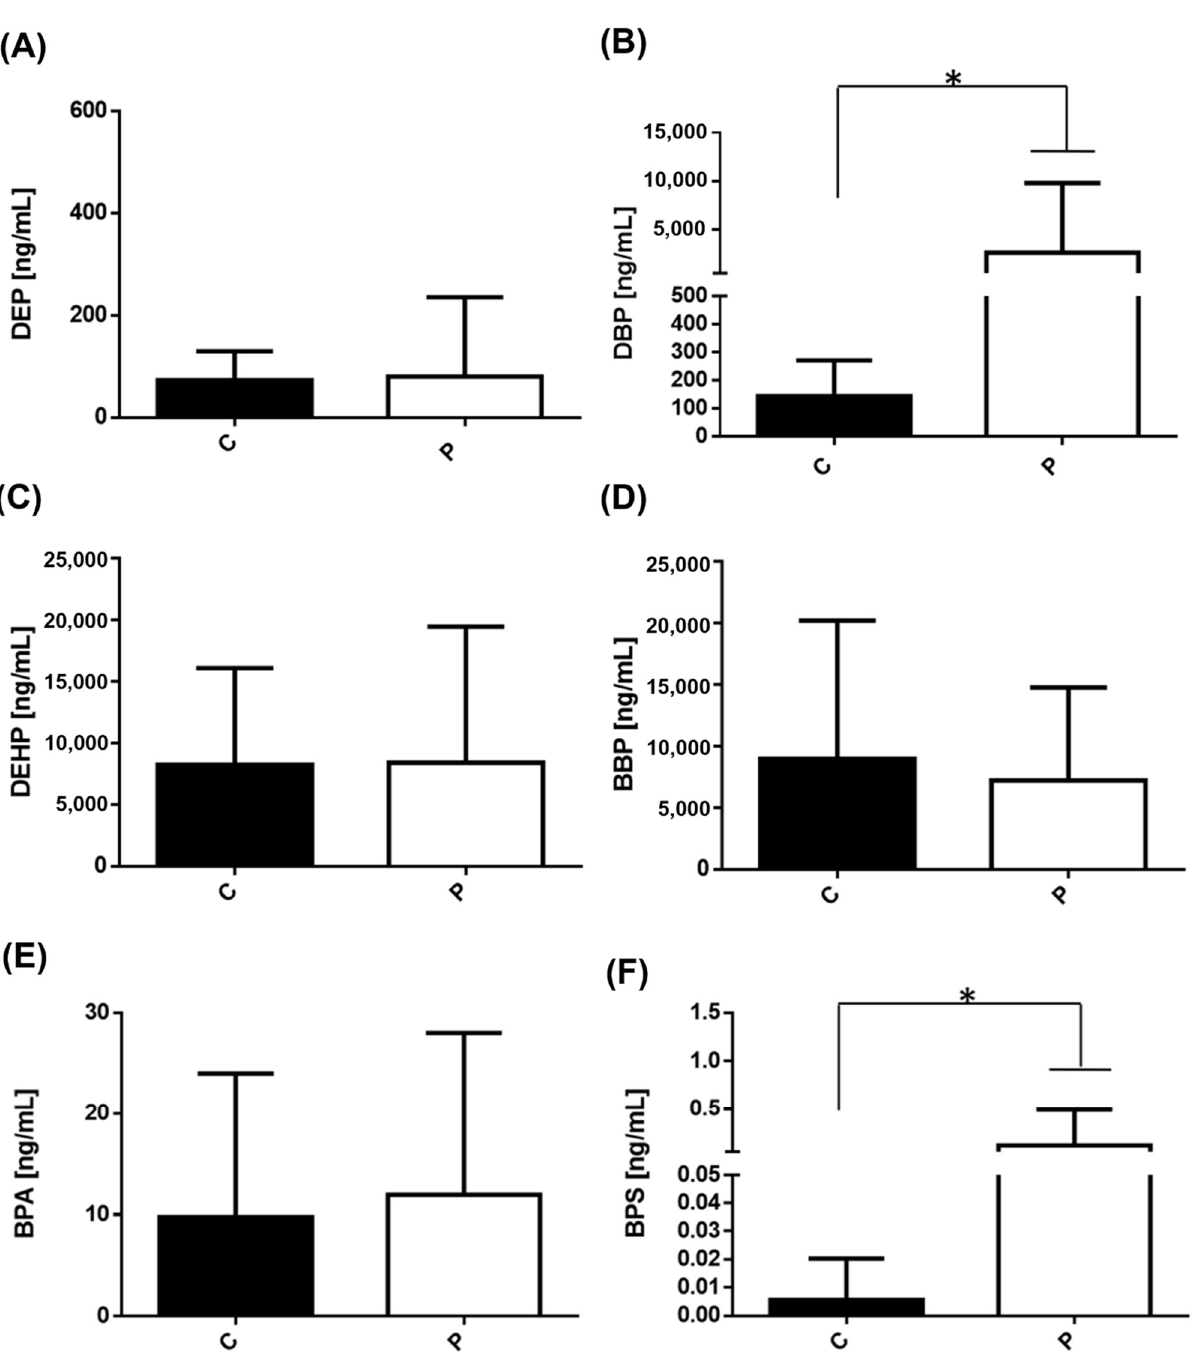
Figure 3. Levels of phthalates and bisphenols in controls and in patients with BC. Serum concentration levels of ( A ) DEP, ( B ) DBP, ( C ) DEHP, ( D ) BBP, ( E ) BPA, and ( F ) BPS were measured in controls (37 subjects/black bar) and in patients with BC (46 subject cases/white bar). Bars represent the mean ± S.D. * p < 0.05 was considered statistically significant.